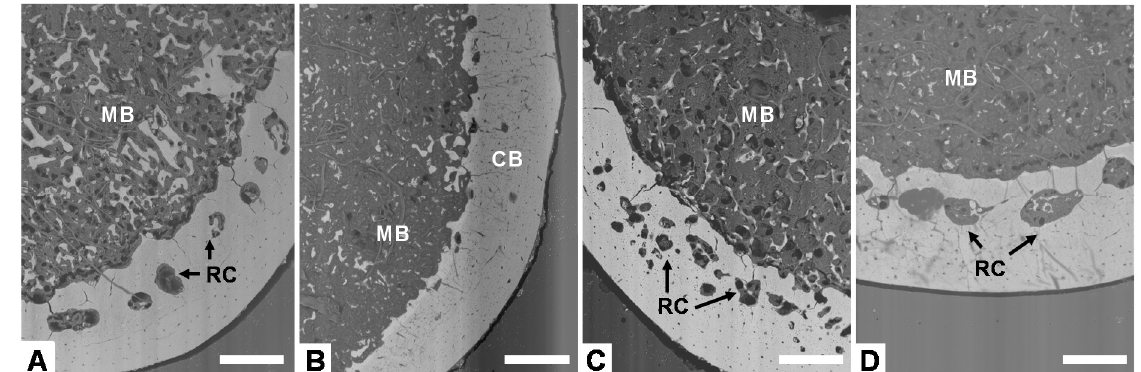
Figure 2. Backscattering electron (BSE-SEM) images of tibia cross-section at mid-shaft from hens of different groups: ( A ) High production, good quality; ( B ) High production, bad quality; ( C ) Low production, good quality; ( D ) Low production, bad quality. CB: cortical bone. MB: Medullary bone. RC: resorption center. Scale bar: 500 μ m.